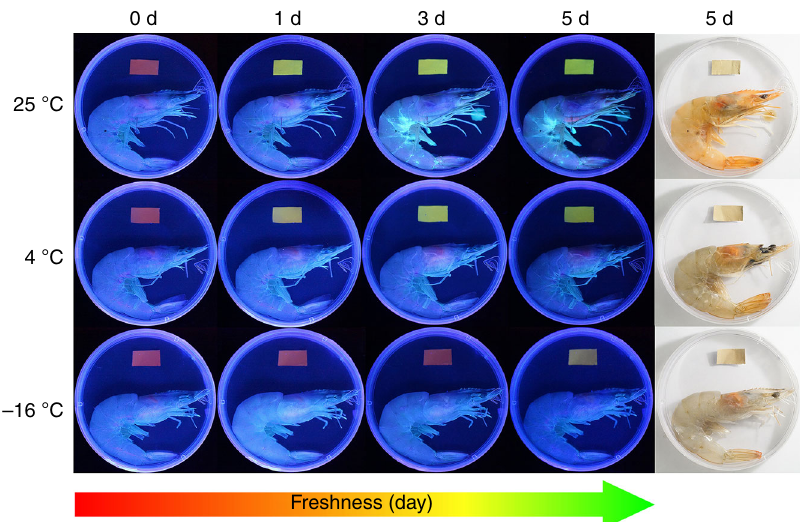
Fig. 4 Monitoring of shrimp freshness by the smart trademark. Images of the cellulose-based ratiometric fl uorescent material with a red initial fl uorescence as a smart trademark for monitoring the freshness of shrimps stored at different